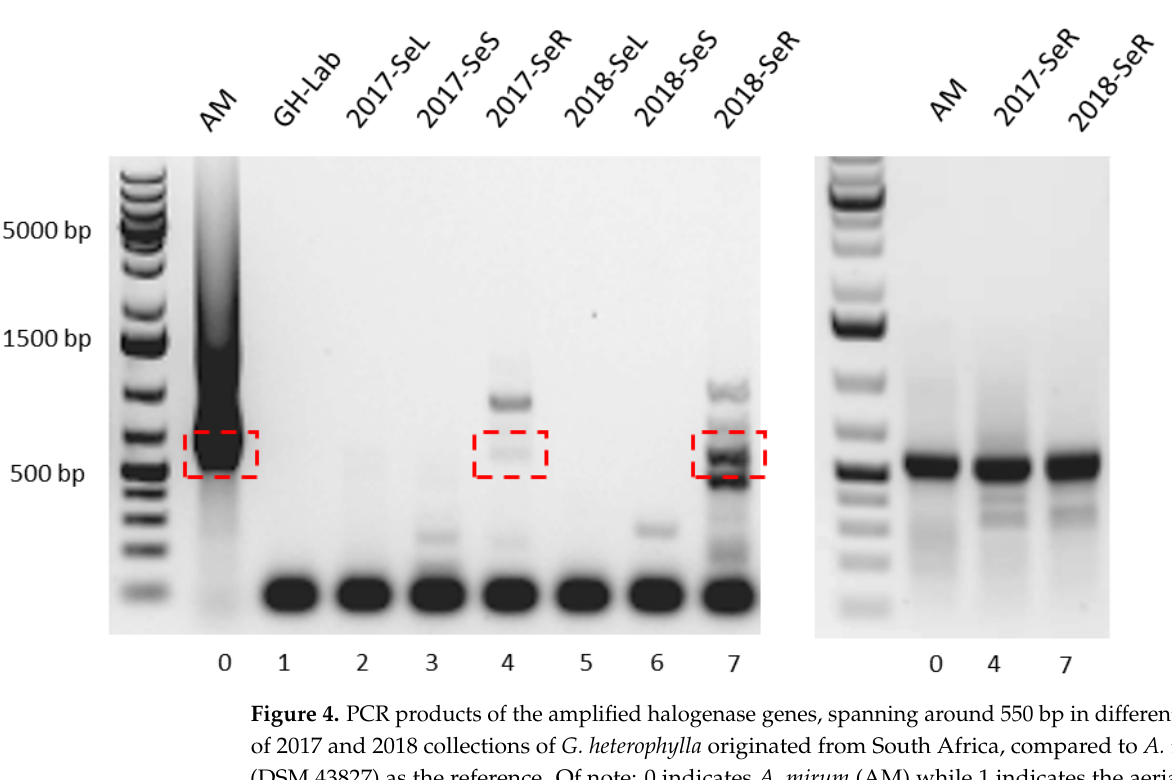
Figure 4. PCR products of the amplified halogenase genes, spanning around 550 bp in different parts of 2017 and 2018 collections of G. heterophylla originated from South Africa, compared to A. mirum (DSM 43827) as the reference. Of note: 0 indicates A. mirum (AM) while 1 indicates the aerial part of G. heterophylla cultivated at our laboratory in Germany (GH-Lab). Additionally, 2 to 4 indicate the leaves, stems, and roots parts of the 2017 collection of G. heterophylla originated from South Africa (2017-SeL, 2017-SeS, and 2017-SeR), while 5 to 7 indicate counterparts from the 2018 collection (2018-SeL, 2018-SeS, and 2018-SeR). The left-handed figure indicates the 1st amplification, while the right-handed one indicates the 2nd amplification, both from the isolated 1st PCR products (red boxes).